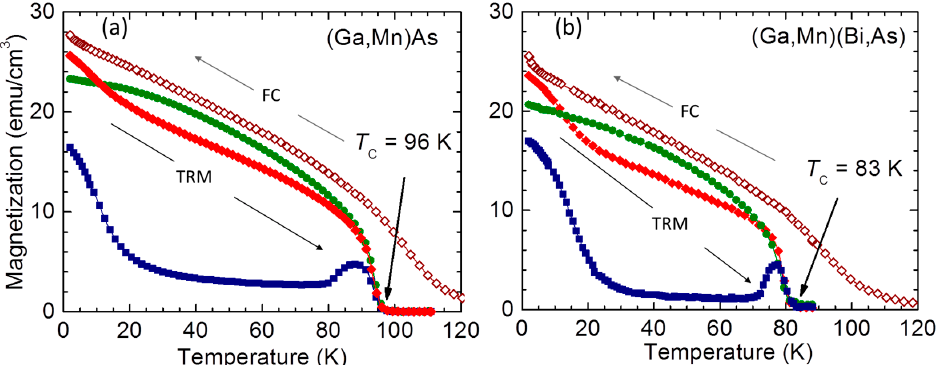
Figure 3. Temperature dependent magnetization M of ( a ) (Ga,Mn)As and ( b ) (Ga,Mn)(Bi,As) layers. On both panels open diamonds represent M collected during field cooling (FC) in μ 0 H = 0.1 T, with magnetic field H applied along the [100] in-plane direction. Solid symbols mark the thermoremnant magnetization, TRM, measured upon warming the samples in the absence of H , right after FC, along the in-plane crystallographic directions: [100]—red diamonds, [ − 110]—green bullets, and [110]—blue squares. The magnitudes of the Curie temperatures, T C , are indicated by